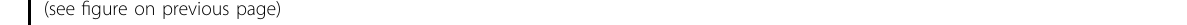
Fig. 1 PAK1 interacts with and phosphorylates STIM1. HEK293 cells were transfected with the PAK1 plasmid (c-myc epitope tagged) and/or with STIM1 plasmid ( fl ag epitope tagged). After determining the expression of the STIM1 and/or PAK1 proteins ( a , middle and bottom rows), the cleared cell lysates were immunoprecipitated with an anti- fl ag (STIM1) antibody, followed by Western blotting with an anti-c-myc (PAK1) antibody. ( a , top row). HeLa cells were treated with 100 nM PDBu for 30 min, and the cell lysates were cleared for immunoprecipitation with an anti-STIM1 antibody and then analyzed by western blotting with an anti-PAK1 antibody ( b ). The GST-STIM1 and GST proteins were expressed in E. coli and, after puri fi cation, were incubated with puri fi ed commercial PAK1 protein followed by western blotting with an anti-PAK1 antibody ( c , d ). The C-terminal cytosolic region of STIM1 or three sub regions of STIM1 were expressed as GST- STIM1 fusion proteins in E. coli ( e , f ). Radioactive in vitro kinase assays were performed by incubating 1 µg of the PAK1 protein and 2 µg of puri fi ed GST-STIM1 fusion proteins in kinase buffer containing [ γ - 32 P] ATP for 30 min at 30 ℃ before subjection to SDS-PAGE and autoradiography. GST was included as a negative control ( g ). EF EF hand motif (Ca 2 + binding), SAM STIM1 oligomerization, TM trans-membrane region, C-C coiled coil domain (Orai1 interaction), P proline rich region, K polybasic cluster, GST glutathione